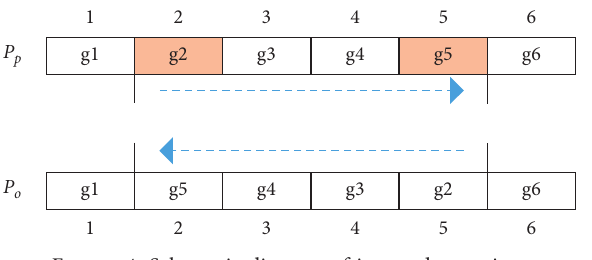
5: Schematic diagram of transformation mutation.